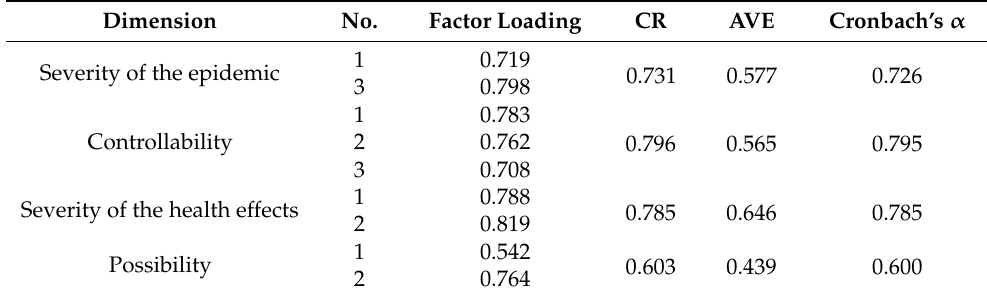
Table 1. Reliability and validity assessment of COVID-19 perceived risk scale. Dimension No. Factor Loading CR AVE Cronbach’s α Severity of the epidemic